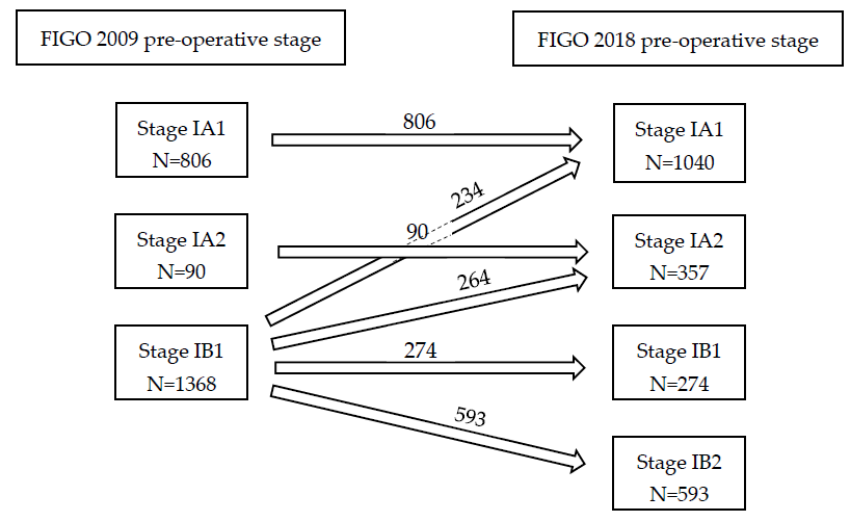
Figure 2. FIGO stage 2009 and allocation to FIGO stage 2018.